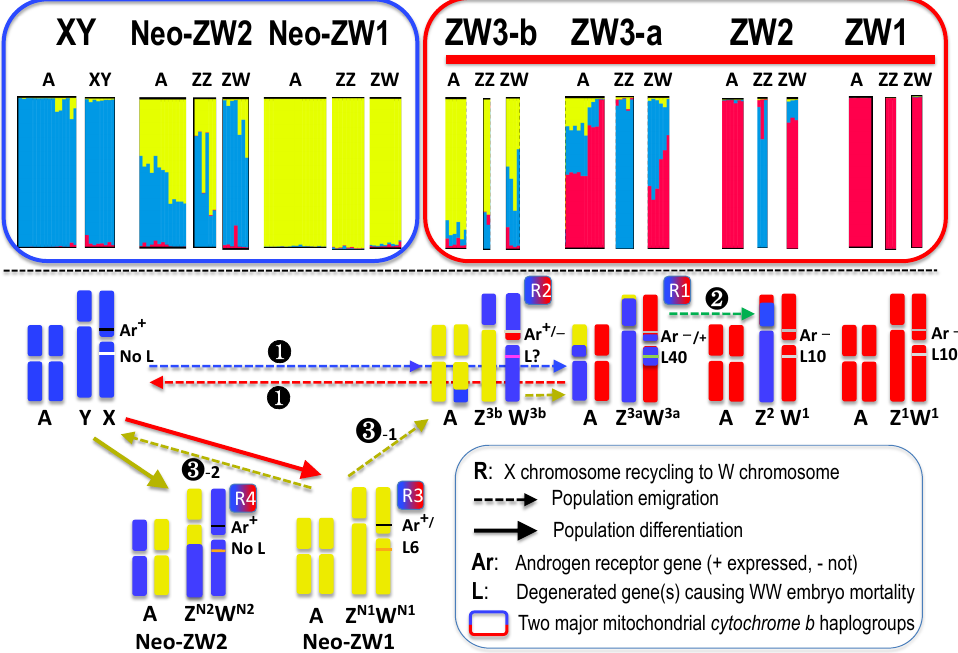
Figure 6. Highlights of autosomal and sex-linked clusters selected from STRUCTURE histograms of the geographic groups and sub-groups (upper) and the assumed genomic structures of autosomes and sex chromosomes (lower). Abbreviations are shown in the box at bottom. Six kinds of Z chromosomes and five kinds of W chromosomes were identified. Population emigrations are indicated by dotted lines with 1, 2, 3 -1 and 3 -2 . Four times reconstruction of the W chromosomes are denoted with R1 – R4.